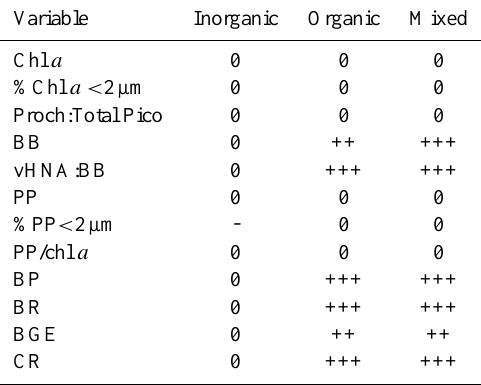
Table 2. Summary of the global effect of the different additions on biological variables (Bonferroni post hoc test): 0, no significant ef- fect; +, significant effect p < 0 . 05; ++, significant effect p < 0 . 01; +++, significant effect p < 0 . 001. +, stimulation, -, inhibition. Chl a , chlorophyll a concentration, %Chl a < 2µm, percentage of to- tal chl a in the fraction < 2µm, Proch:Total Pico., Prochlorococcus : Total picophytoplankton biomass ratio, BB, heterotrophic bacterial biomass, vHNA: BB, vHNA: Bacterial Biomass ratio, PP, primary production, %PP < 2µm, percentage of total PP due to the frac- tion < 2µm, PP/chl a , primary production to chlorophyll a ratio, BP, bacterial production, BR, bacterial respiration (estimated from in vivo ETS activity due to the fraction < 0.8µm), BGE, bacterial